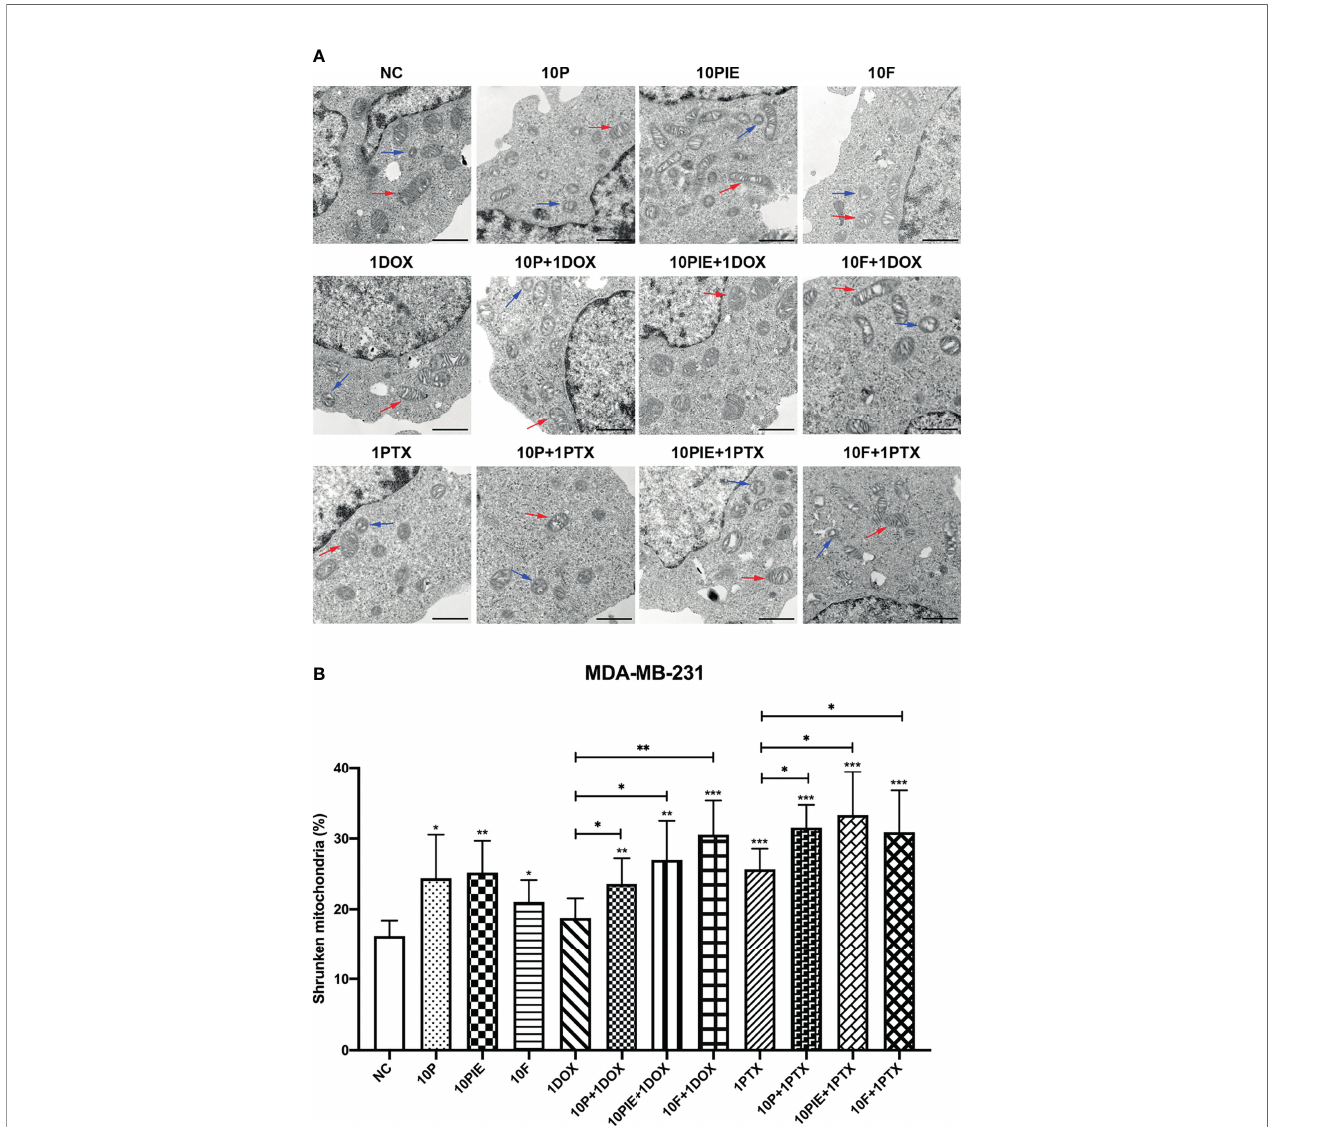
FIGURE 4 | Ferroptosis-related mitochondria morphological changes in MDA-MB-231 cells administered propofol/PIE/fospropofol disodium with or without doxorubicin/paclitaxel. (A) Ferroptosis-related mitochondria morphological changes in MDA-MB-231 cells treated with different drugs were determined using TEM. Red arrows: normal mitochondria. Blue arrows: shrunken mitochondria. Bar = 1 µm. (B) Statistical analysis of shrunken mitochondria percentage in MDA-MB-231 cells under different treatments. * P < 0.05, ** P < 0.01, *** P <